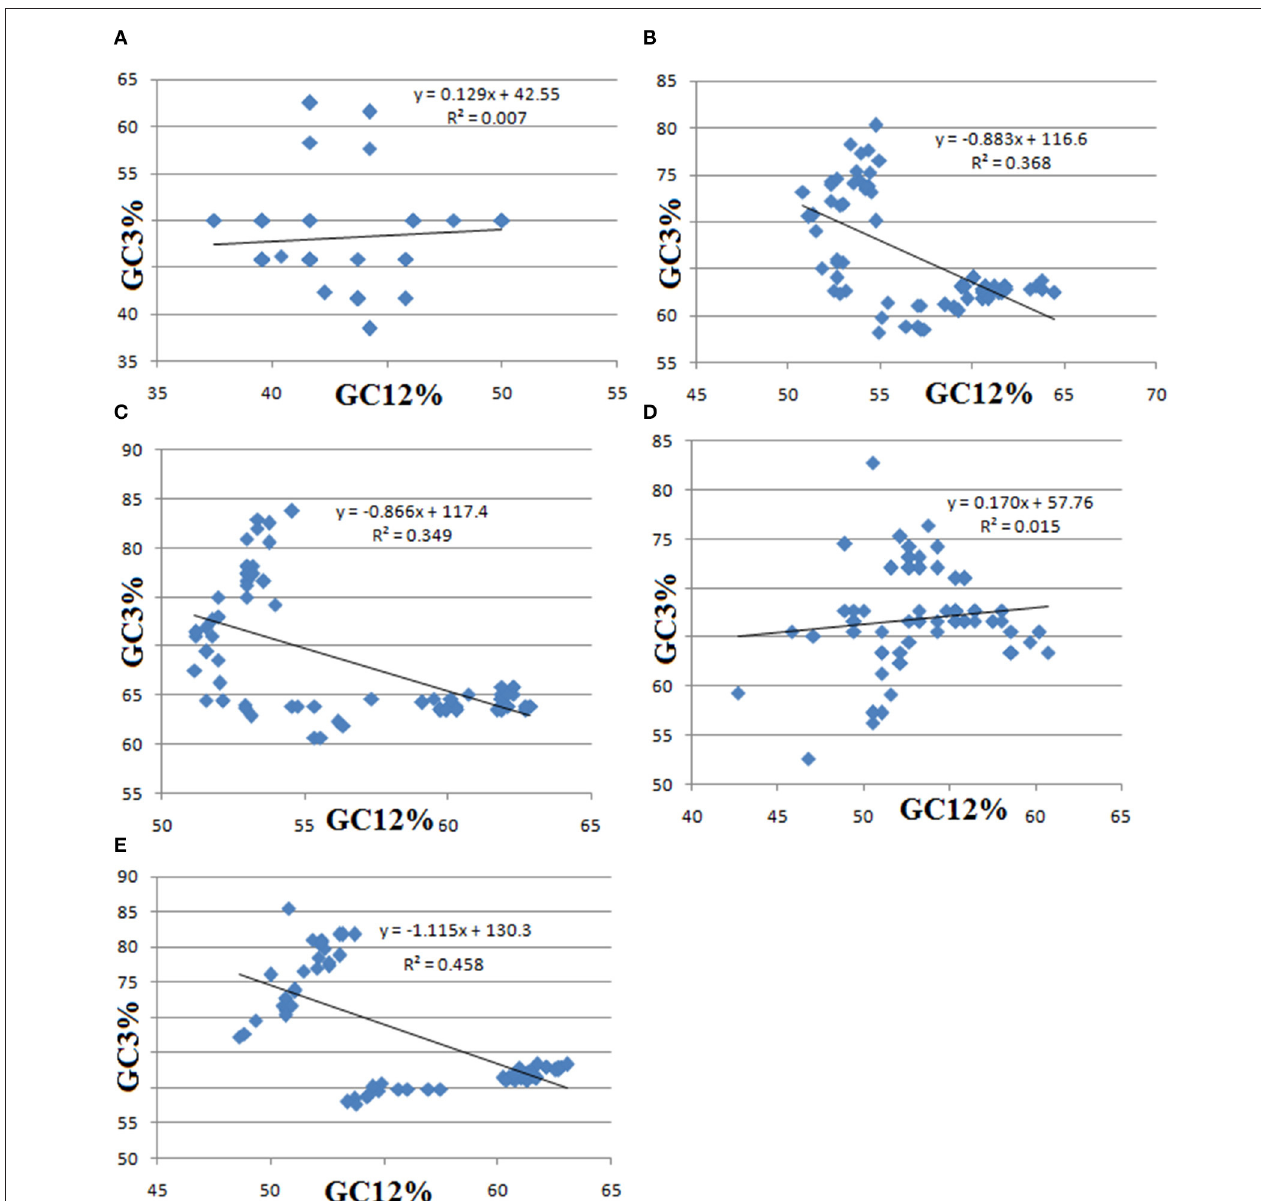
FIGURE 4 | Neutrality plot of GC12% and GC3% contents of pqqA (A) , pqqB (B) , pqqC (C) , pqqD (D) , and pqqE (E) genes of Cronobacter , Klebsiella , Kosakonia , Pantoea , Rahnella , and Serratia . In this regression plot, GC12 ( y -axis) represents the average value of GC contents at the first and second positions in each codon, and GC3 ( x -axis) is the GC content at the third